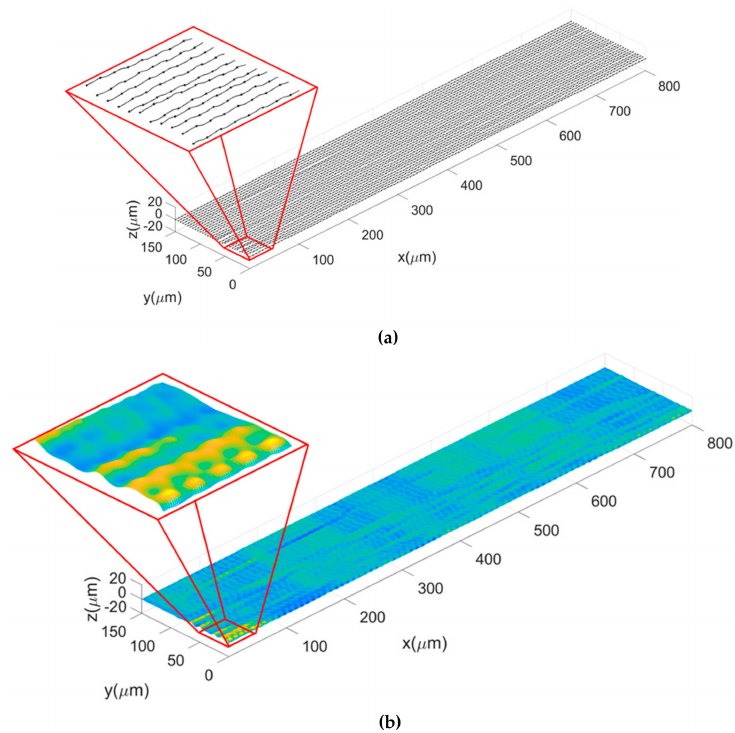
Figure 5. Measured profiles and the simulated surface of a smooth specimen (Specimen No. 3): ( a ) measured profile data and ( b ) a generated NURBS surface.